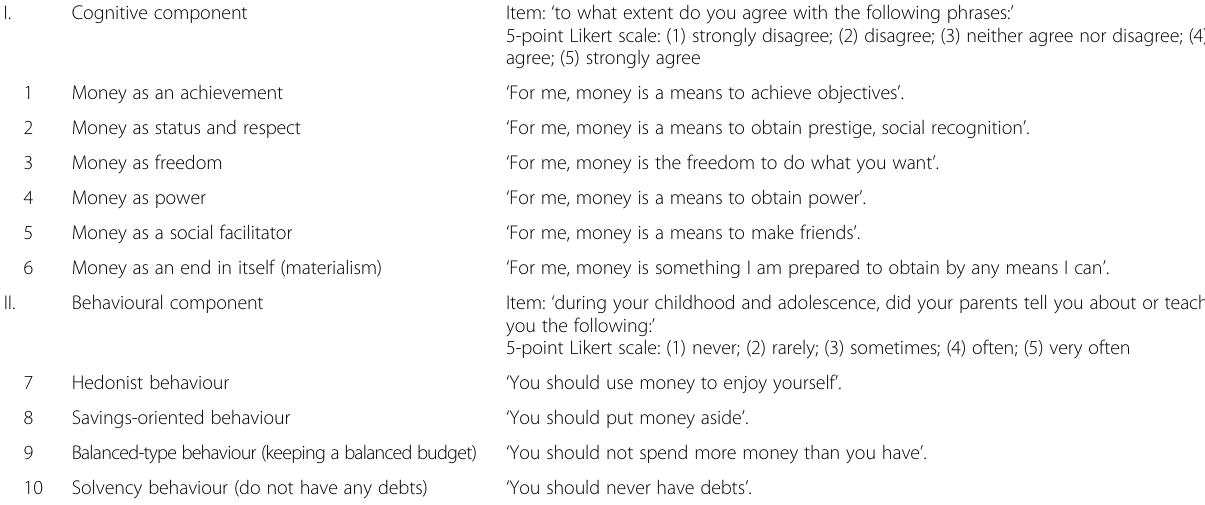
Table 1 The 10-dimensional instrument measuring attitudes towards money